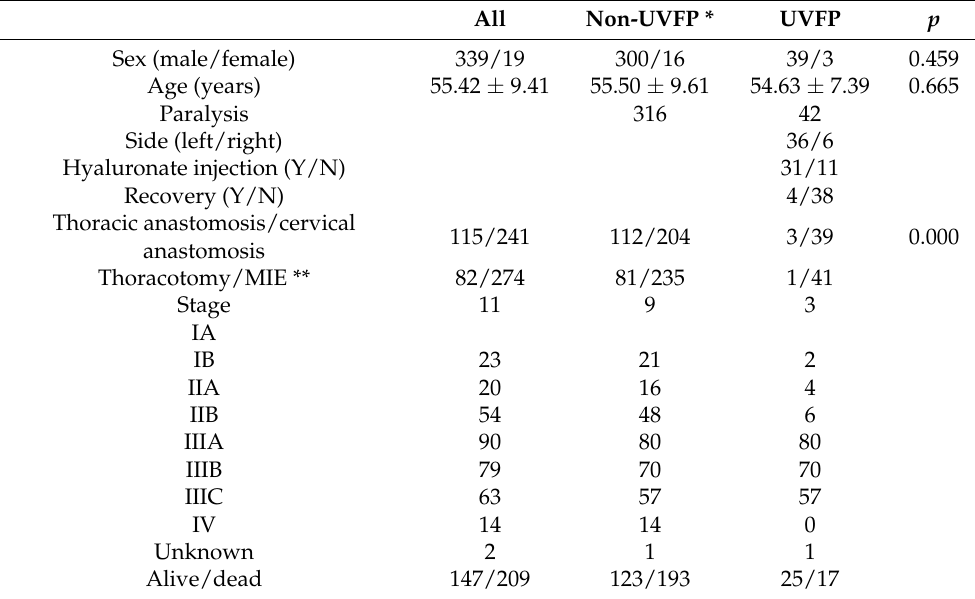
Table 1. Patient characteristics of the enrolled group.